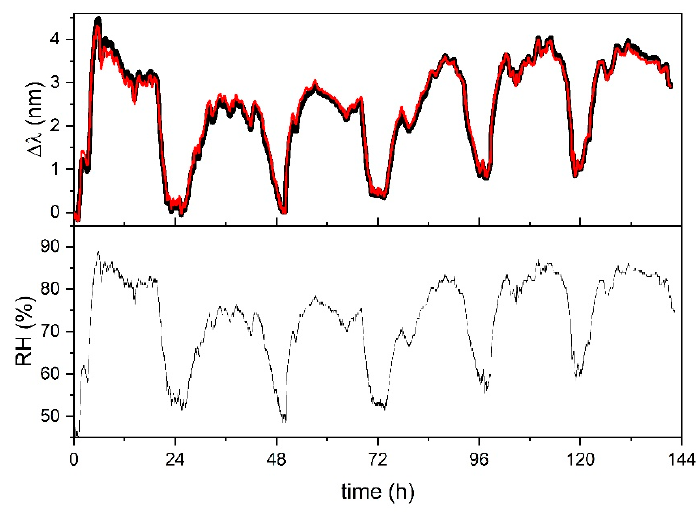
Figure 9. Response of sample FBG-FP (black) and sample FBG-FP-S (red) for six days in October. RH value was measured by the reference thermo-hygrometer.